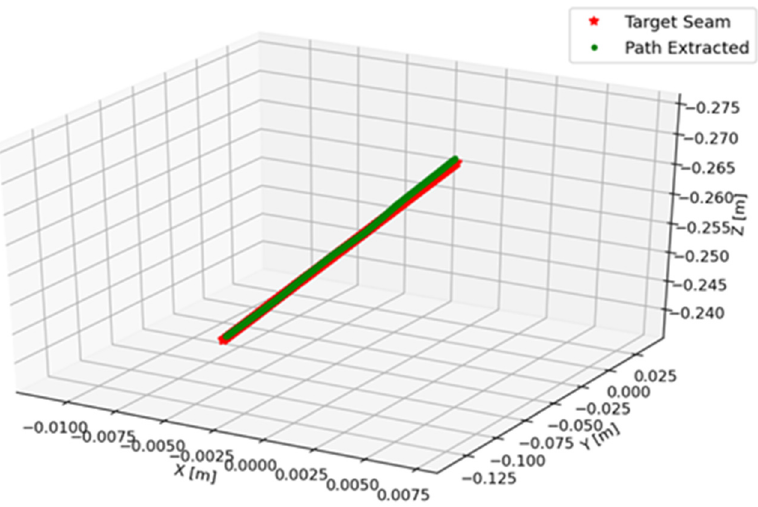
Figure 11. Target straight butt joint trajectory vs. computed trajectory.